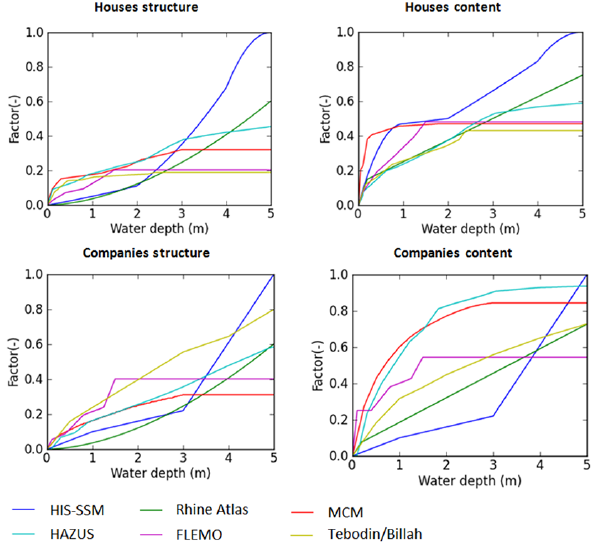
Figure 2. Average damage functions for the different flood dam- age models in the damage function library. Blue: HIS-SSM, green: Rhine Atlas, red: MCM, light blue: FLEMO, pink: HAZUS, yellow: Billah (2007) for houses and Tebodin for companies.